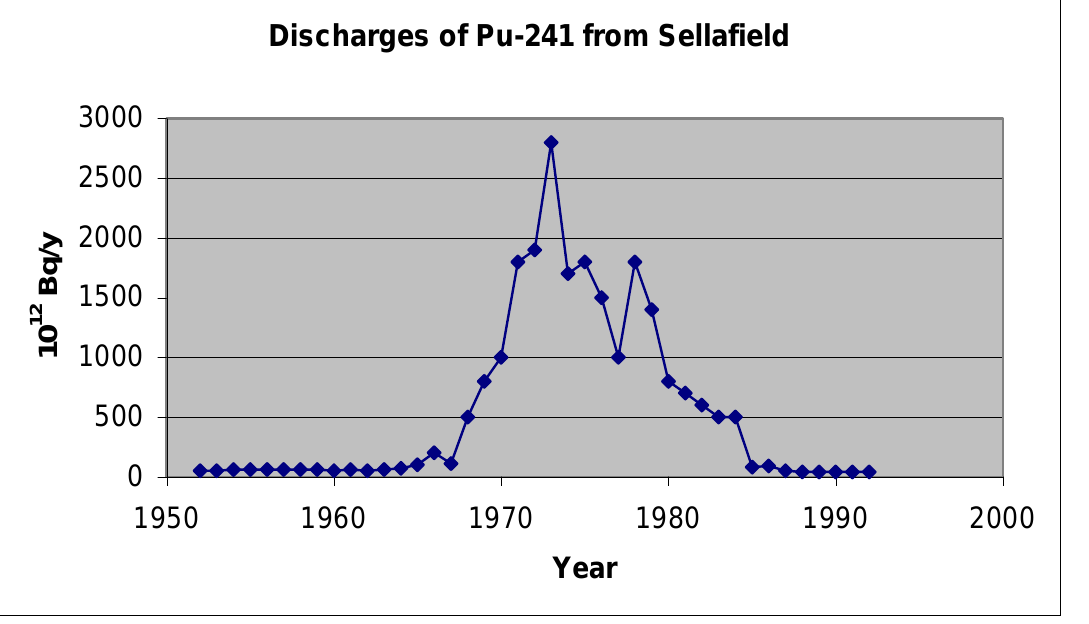
FIGURE 8 . Discharges of beta-emitting Pu from Sellafield nuclear reprocessing plant, 10 12 Bq/year.